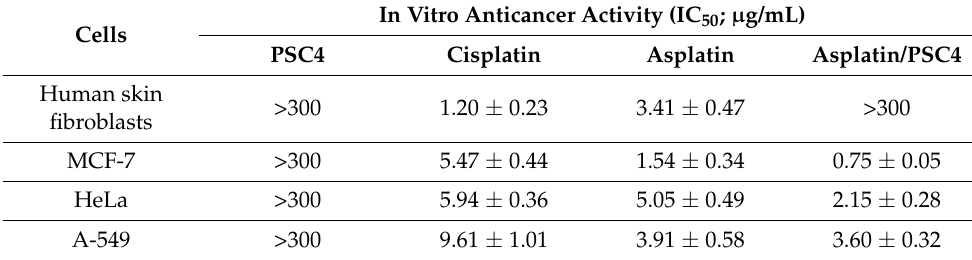
Table 2. In vitro anticancer activities of PSC4, cisplatin, asplatin, and asplatin/PSC4 against human skin fibroblast, MCF-7, HeLa, and A-549 cell lines a .